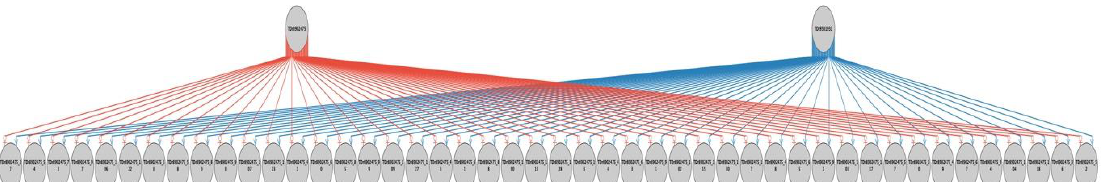
Figure 3. Pedigree reconstruction of polycross family TDr1686 based on Helium pedigree visualization . TDr9501932 and TDr9902607 = male parents (blue); TDr8902157 = female parent (red).